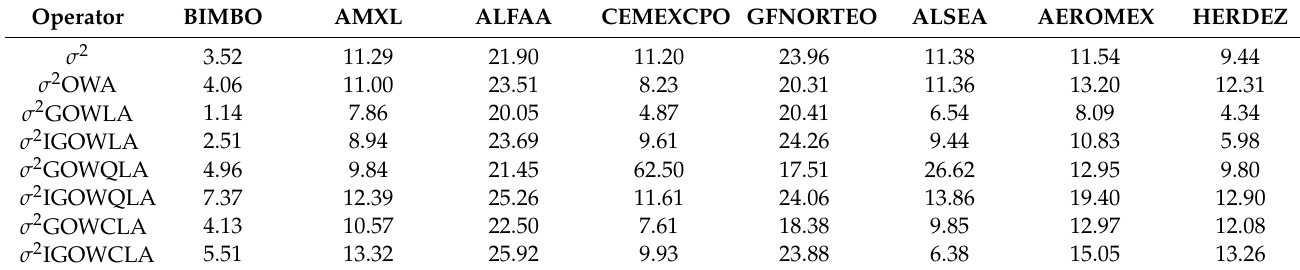
Table 5. Dispersion aggregated results.